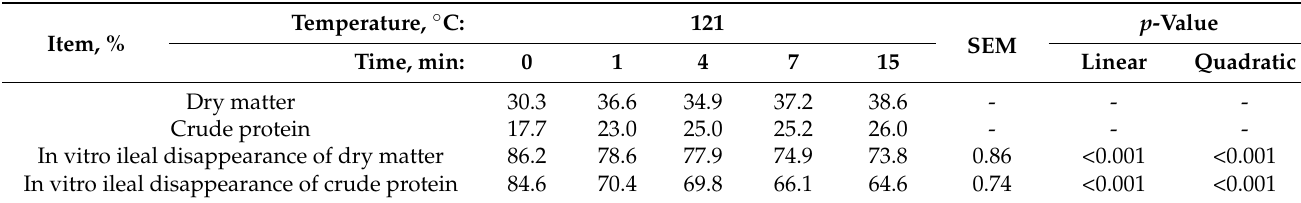
Table 3. Dry matter and crude protein concentrations in chicken meat autoclaved at 121 ◦ C (as-is basis) and the effects of heating time on in vitro ileal disappearance of dry matter and crude protein of chicken meat autoclaved at 121 ◦ C (Exp. 3) 1